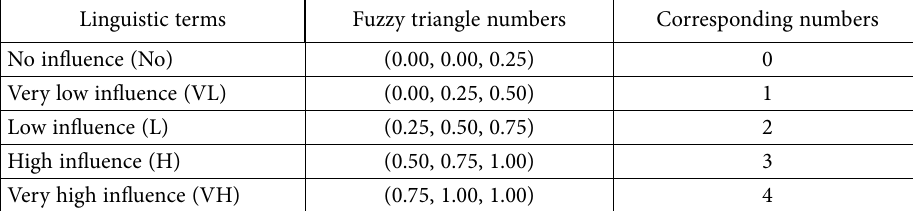
Table 2. Values incorporated to the fuzzy triangle linguistic terms Linguistic